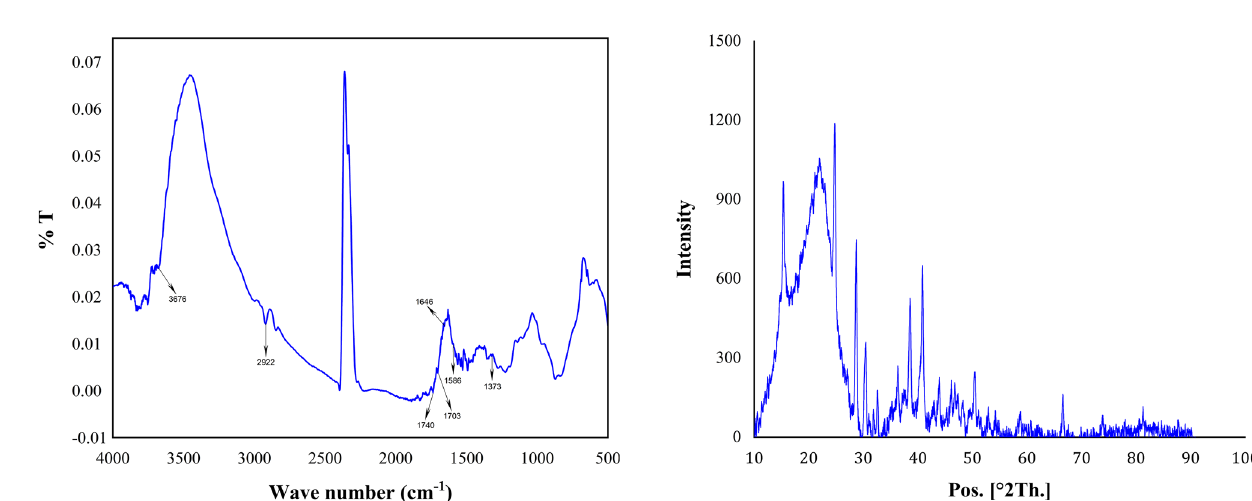
Fig. 8 Total phosphorus reduction by the coagulants